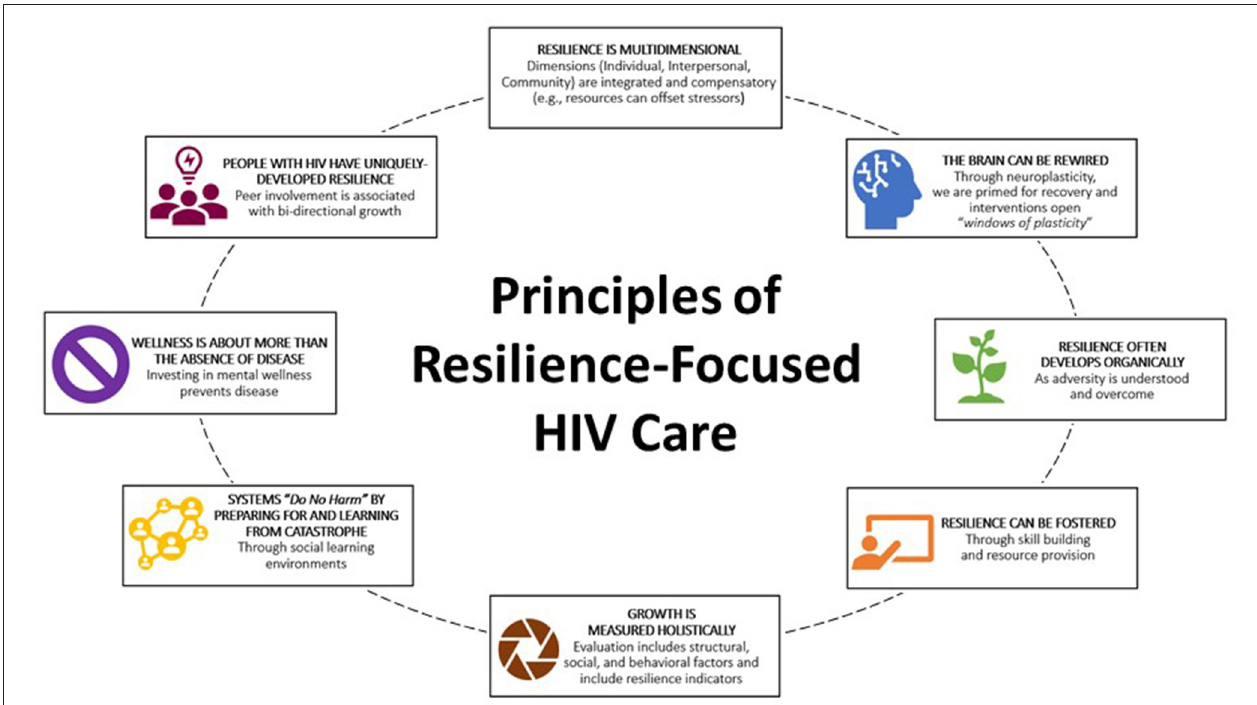
FIGURE 1 | Principles of resilience-focused HIV care. Source: Authors’ synthesis of the literature.